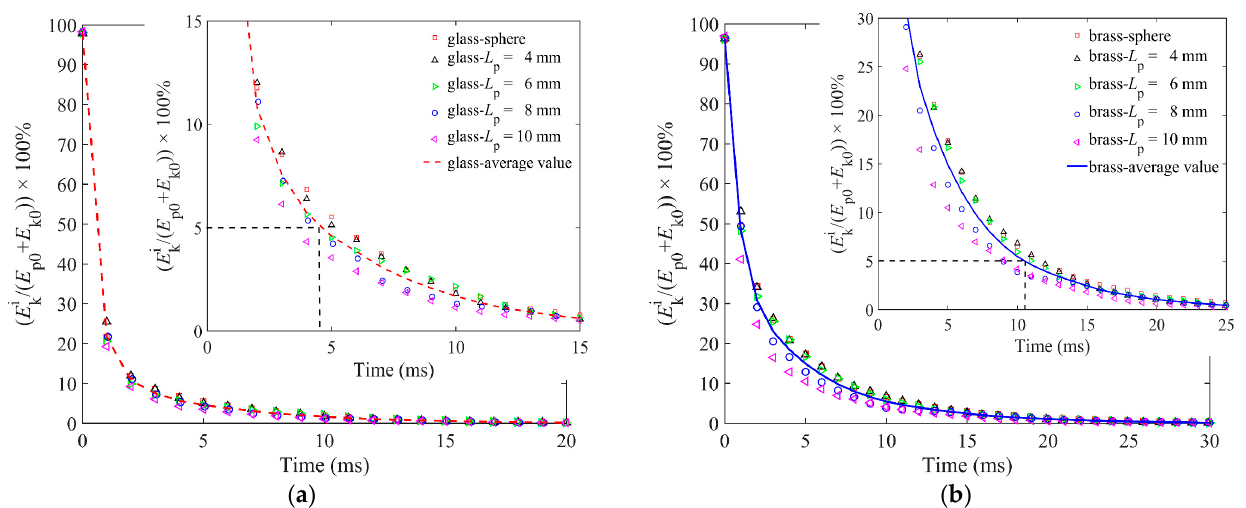
Figure 7. Kinetic energy of impactor E i as a function of time for granular bed of spherical particles and elongated particles of four lengths: ( a ) is for the glass impactor, and ( b ) is for the brass impactor.